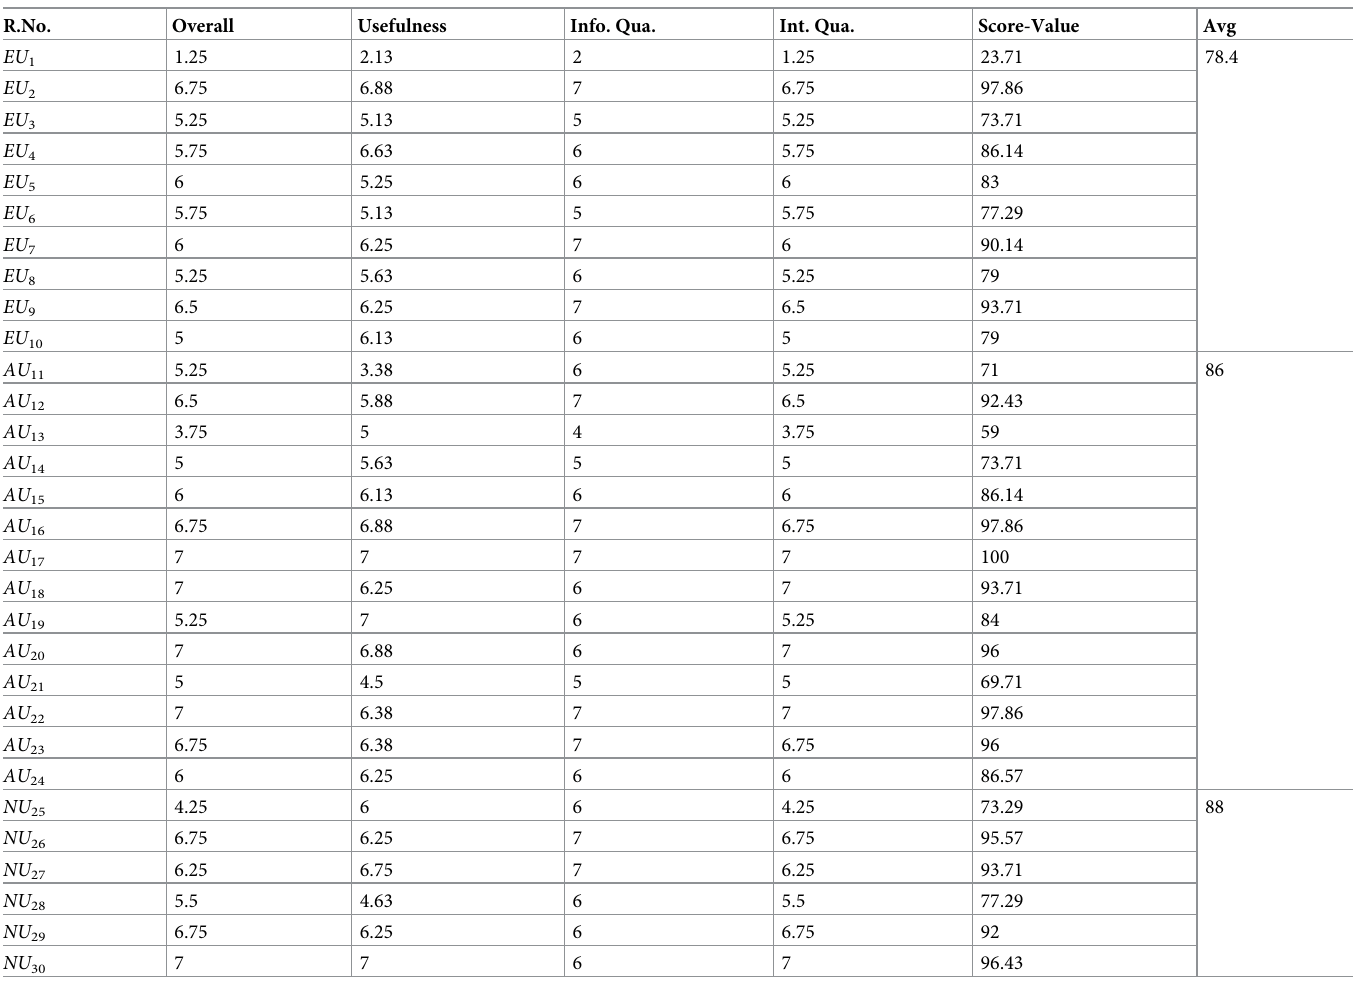
Table 3. Respondents CUSQ evaluation